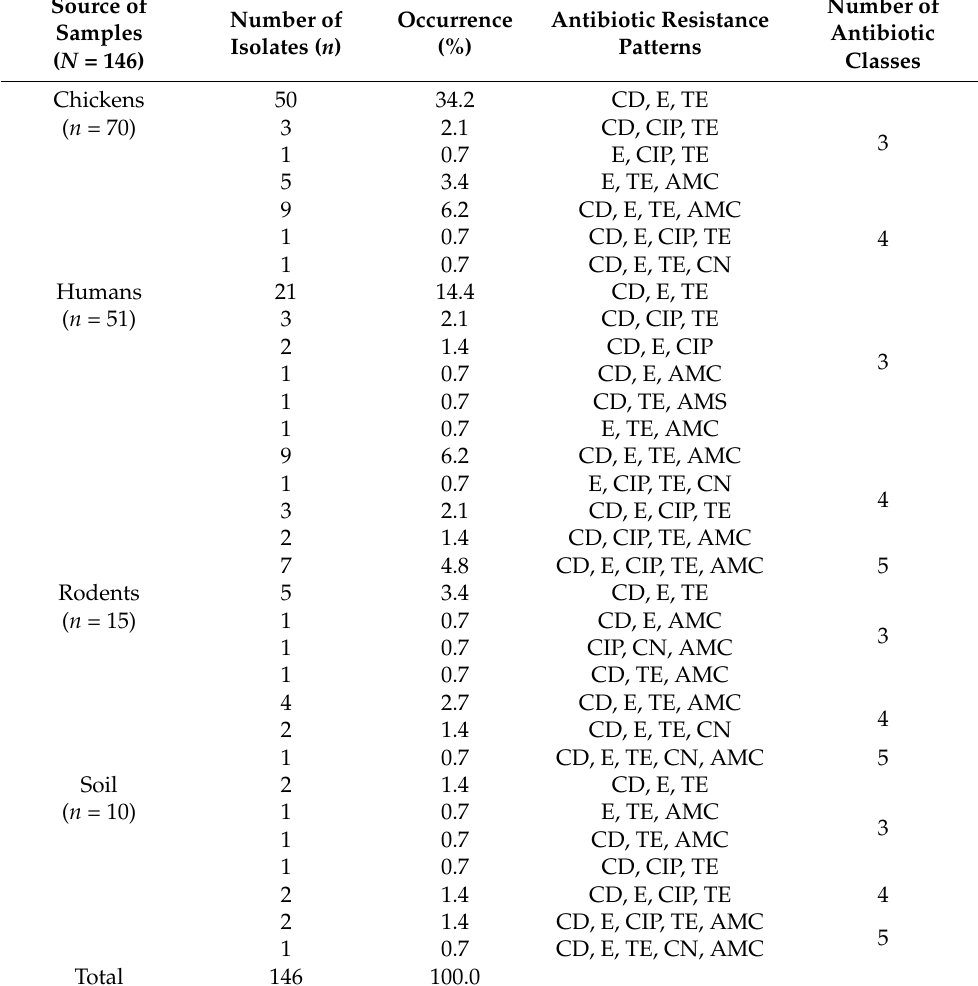
Table 5. Phenotypic resistance patterns of MDR S. aureus isolates from chickens, humans, rodents, and soil